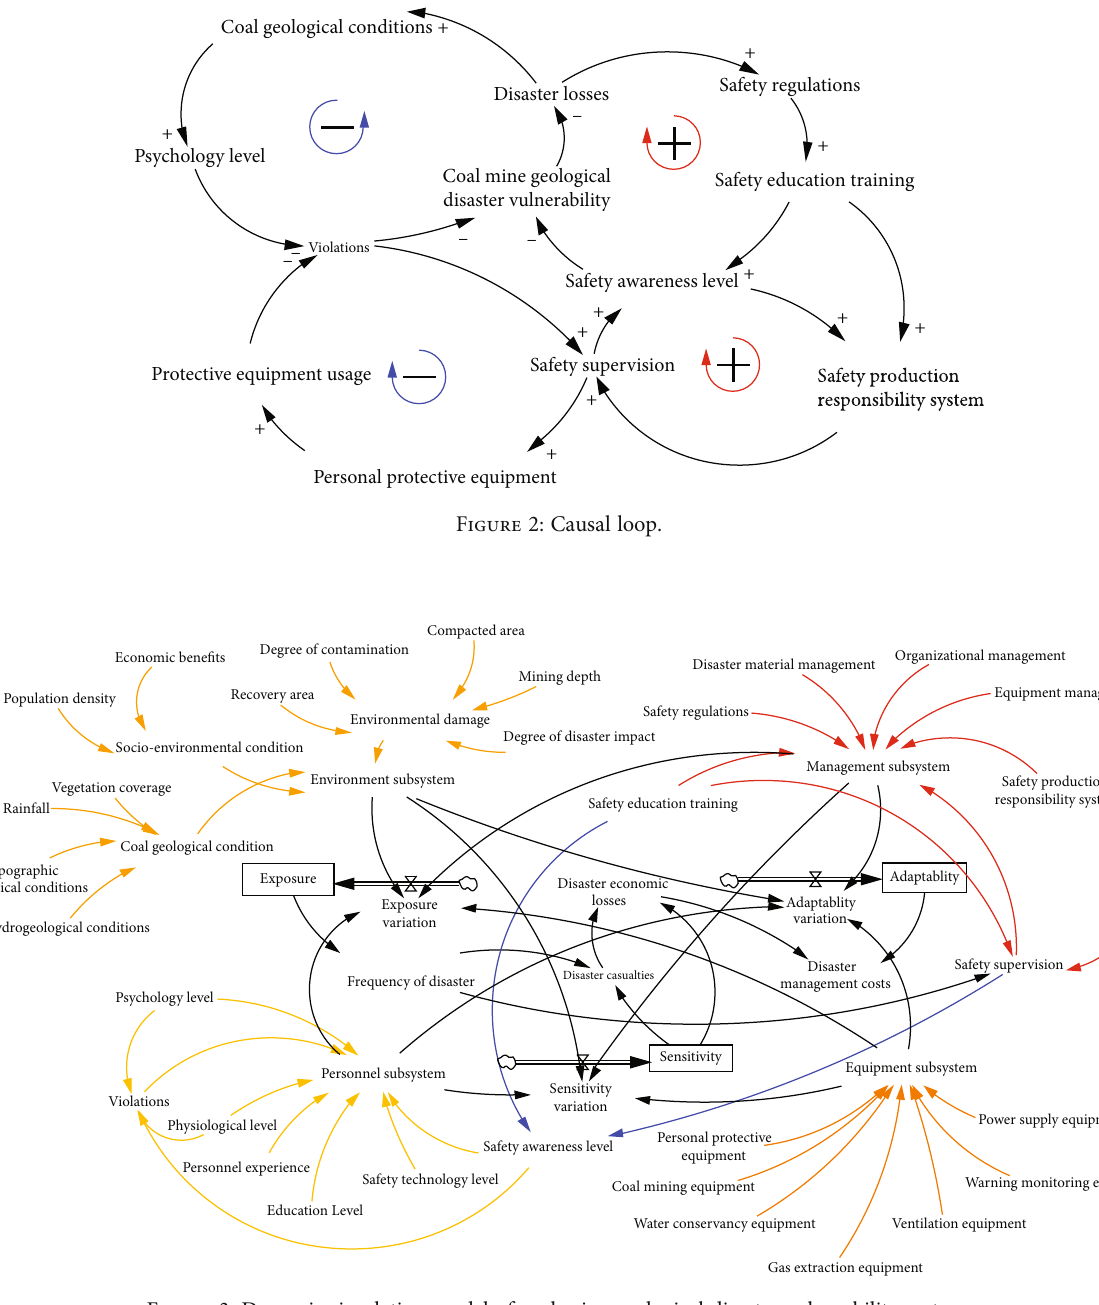
Figure 3: Dynamic simulation model of coal mine geological disaster vulnerability